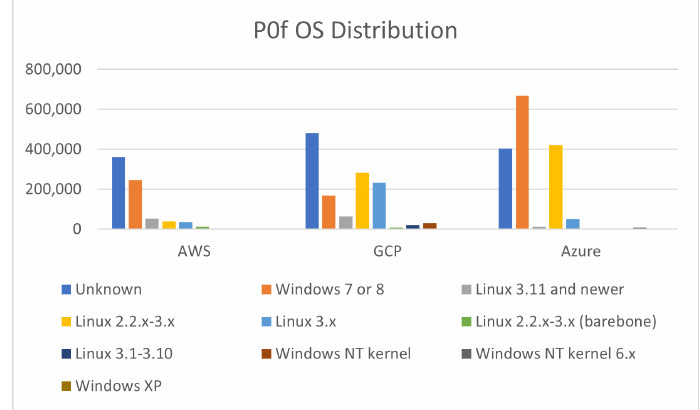
Figure 15. OS Distribution Comparison.